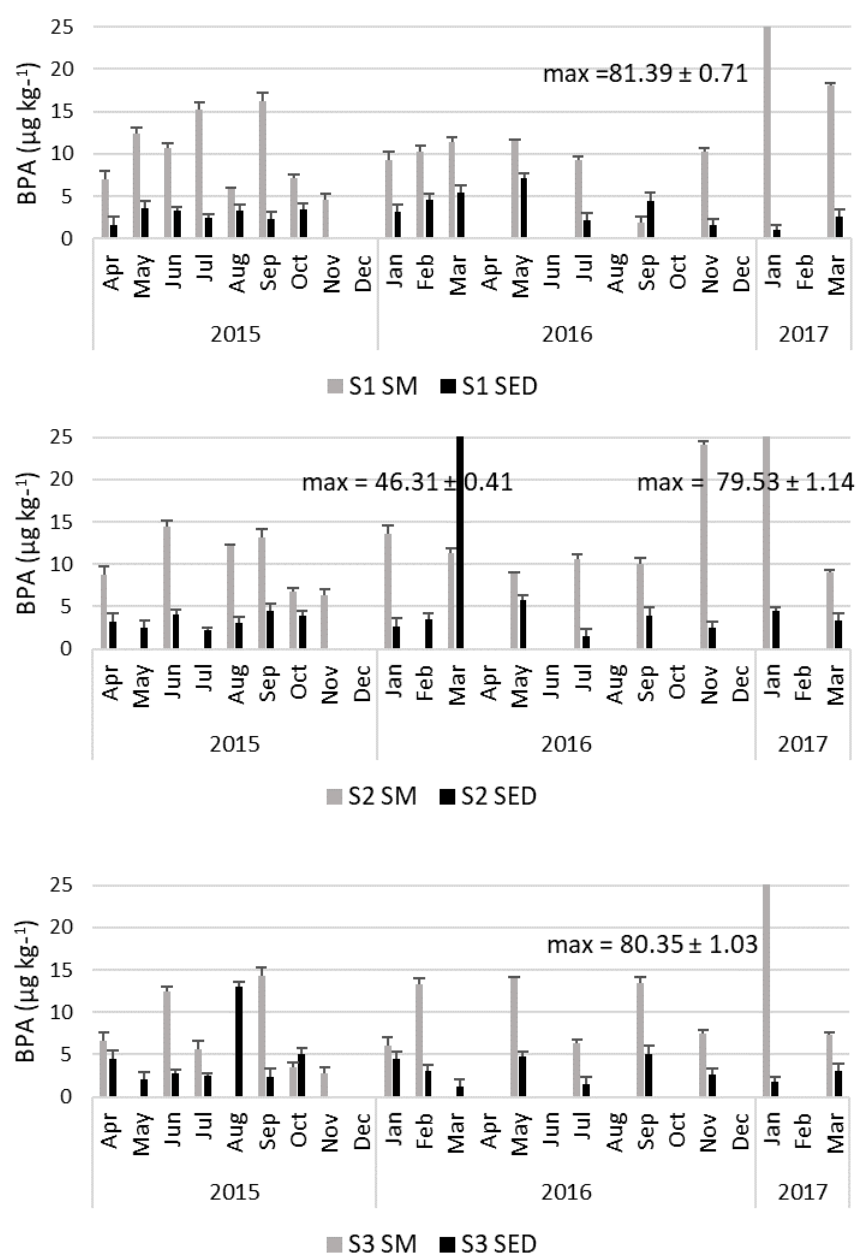
Figure 6. Bisphenol A (BPA) concentrations in the suspended matter (SM) and sediment samples (SED) collected over two years (April 2015 to March 2017) at stations S1 to S3 in the Kaštela Bay (Adriatic Sea, Croatia).